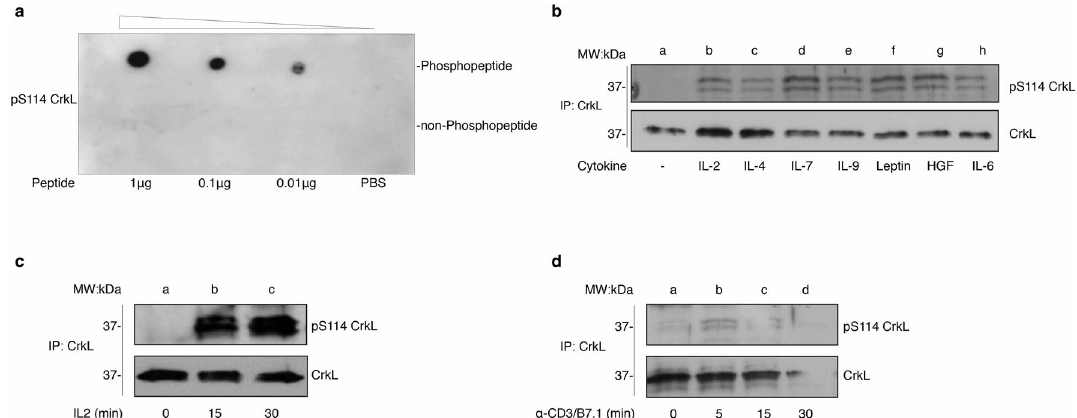
Figure 5. The CrkL pS114 antibody preferentially recognizes phosphorylated peptides and detects CrkL S114 phosphorylation induced by several cytokines. ( a ) Phosphopeptide (MGSV 33 APNLPTAEDC) and non- phosphopeptide (MGSVSAPNLPTAEDC) were spotted onto PVDF membrane in decreasing amounts along with vehicle control (PBS). The resulting membrane was Western blotted using α-pS114 polyclonal antibodies. ( b ) Quiescent Kit225 cells were stimulated with various growth factors cytokines including IL-2 (100 nM, lane b ), IL-4 (100 nM, lane c ), IL-7 (100 nM, lane d ), IL-9 (100 nM, lane e ), Leptin (10 ng/ml, lane f ), HGF (100 ng/ ml, lane g ) or IL-6 (400 ng/ml, lane h ) for 15 min. Cell lysate was immunoprecipitated for CrkL, Western blotted using α-pS114 polyclonal antibodies and re-blotted for total CrkL. Shown is representative data of two independent experiments (n = 2). Full-length blots are displayed in Supplementary Fig. S5a. ( c ) Quiescent Kit225 cells were stimulated without (lane a ), with 100 nM IL-2 for 15 min (lane b ) or 30 min (lane c ). Cell lysates were immunoprecipitated using CrkL antibodies, Western blotted using α-pS114 polyclonal antibodies and re-blotted for total CrkL. Full-length blots are displayed in Supplementary Fig. S5b. ( d ) Jurkat cells were stimulated with α-CD3 (5 µg) monoclonal antibodies and rhB7.1 (100 ng) for 0, 5, 15, and 30 min (lanes a – d ). Cell lysate was subjected to immunoprecipitation for CrkL, protein and Western blotted with polyclonal α-pS114 CrkL antibodies. Full-length blots are displayed in Supplementary Fig.